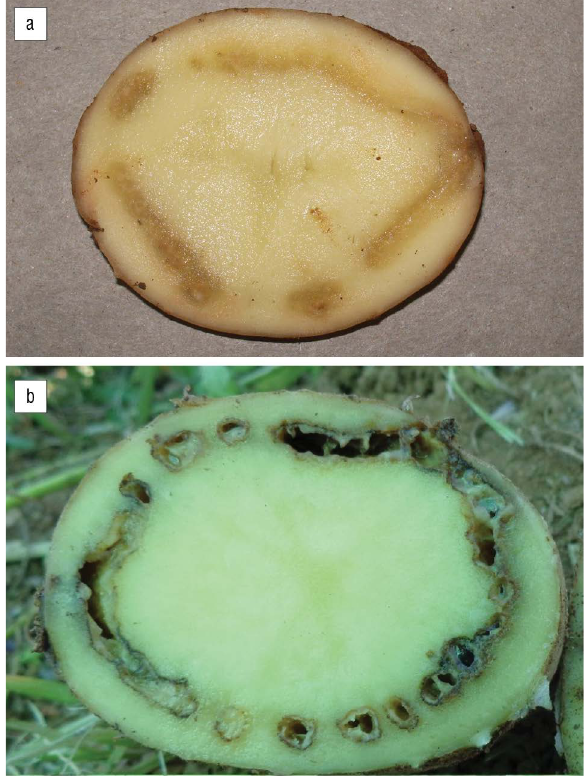
Figure 2: (a) Initial and (b) advanced symptoms of brown rot in potato tubers (images: Fienie